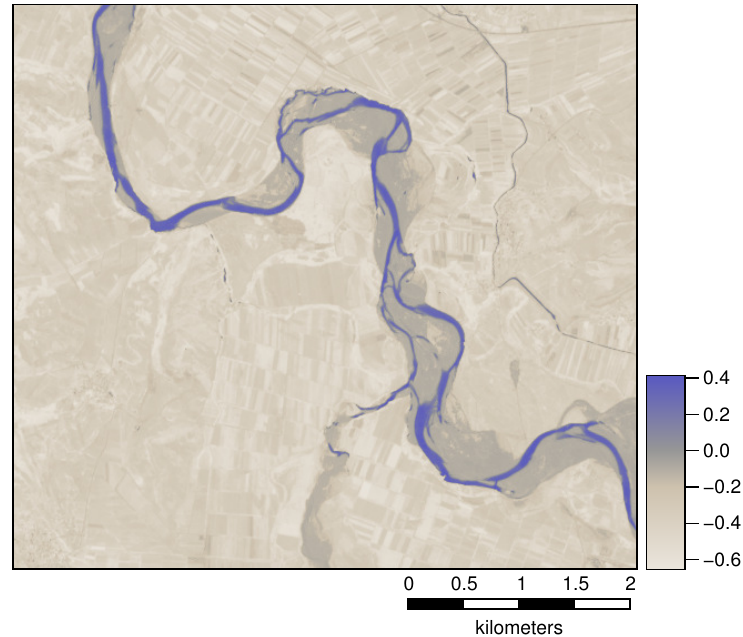
Figure 3. Example of the NDWI map of the Vjosë River, Sentinel-2 data.